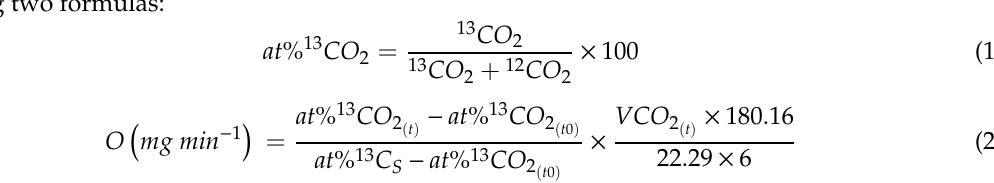
table of non-protein RER [15]. Starch-derived glucose oxidation (SGO) rates were calculated using